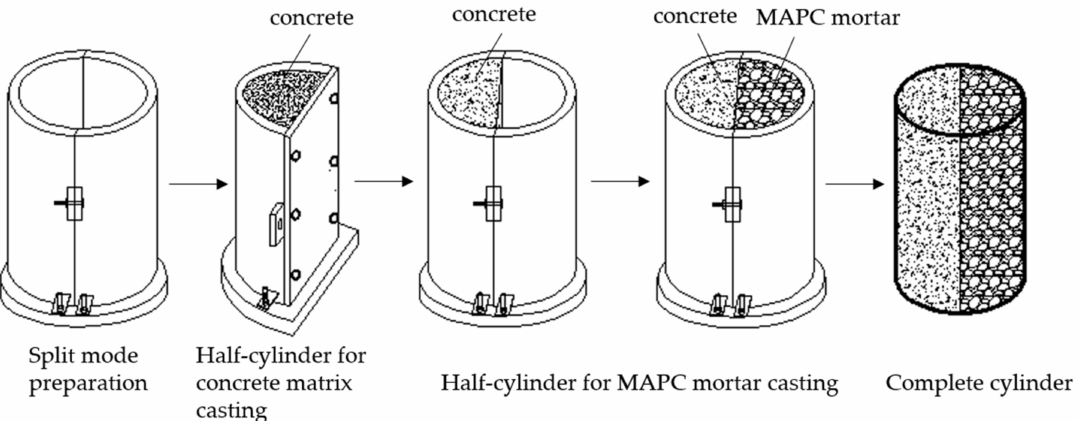
Figure 2. Sample preparation for test on interfacial bonding strength of MAPC mortar with ordinary concrete